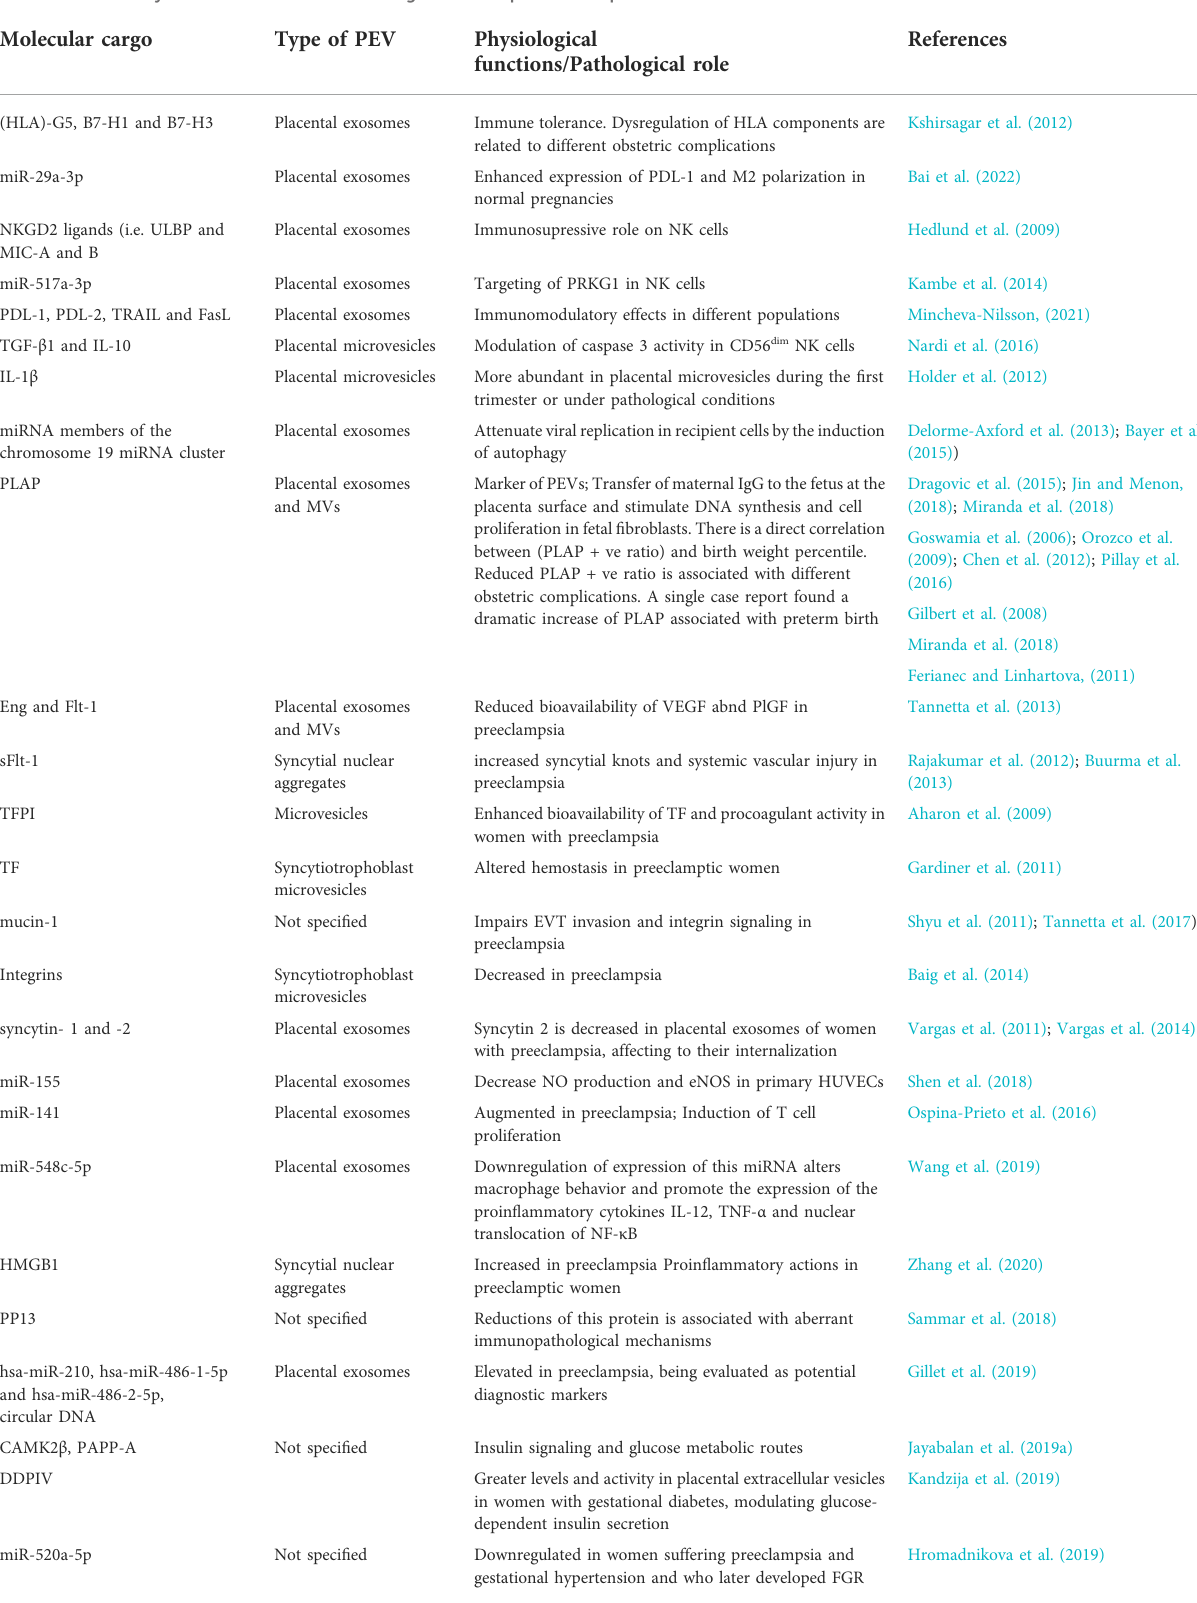
TABLE 1 A summary of the main molecular fi ndings and their potential implications in